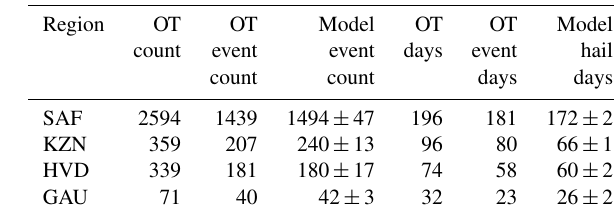
Table 3. Annual severe convective storm characteristics for South Africa, estimated from 14-year periods for the greater South Africa domain (SAF), KwaZulu-Natal (KZN), the Highveld (HVD), and Gauteng